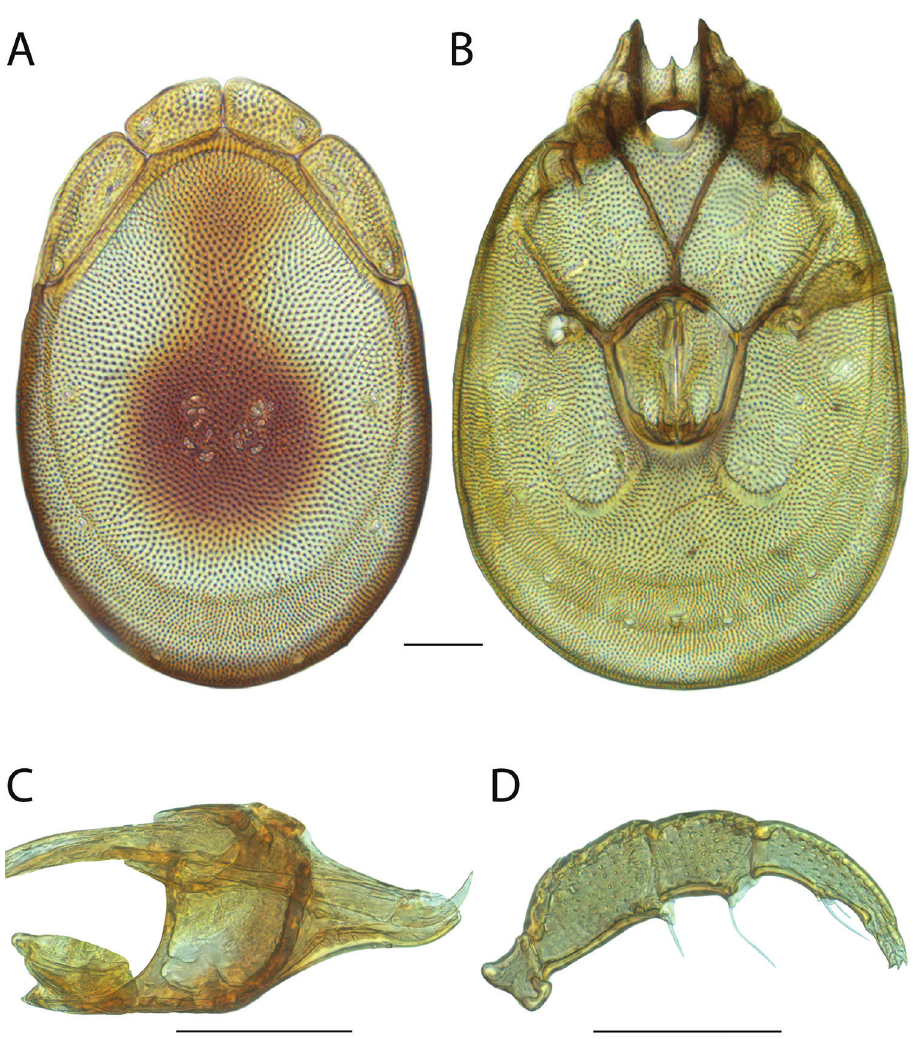
Figure 39. Torrenticola cardia sp. n. female: A dorsal plates B venter (legs removed) C subcapitulum D pedipalp (setae not accurately depicted). Scale = 100